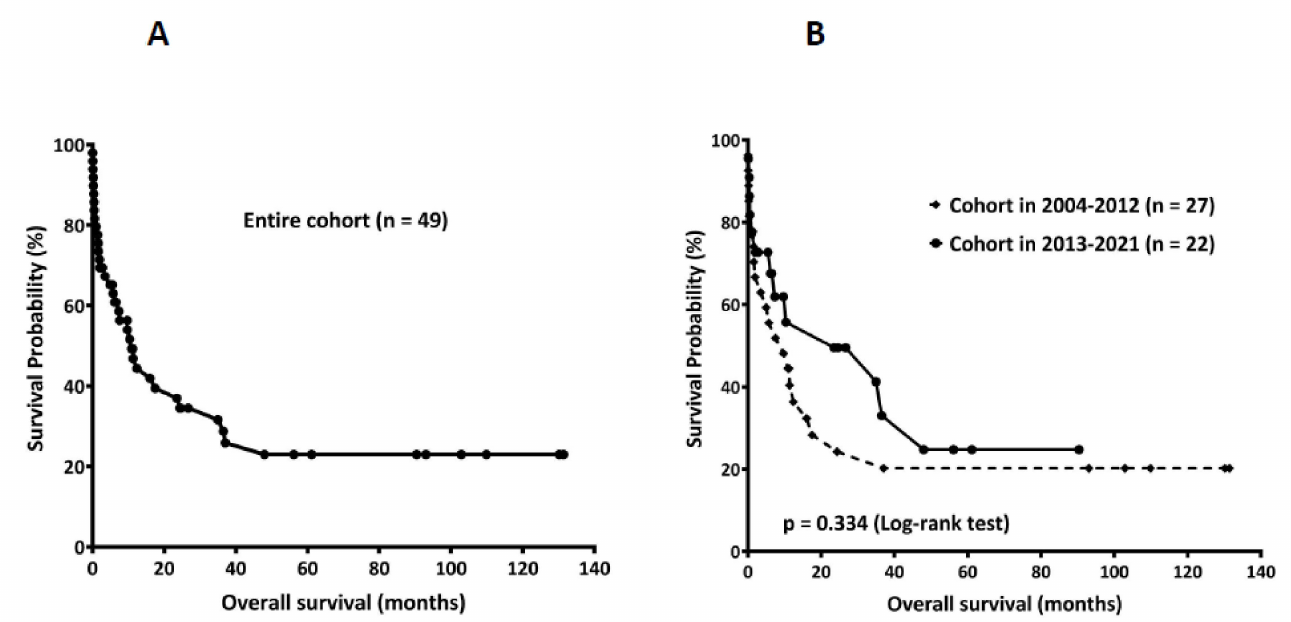
Figure 1. The overall survival (OS) in patients of lymphoma-associated hemophagocytic lymphohistiocytosis. ( A ) The median OS of the whole study population ( n = 49) was 10.9 ± 3.0 months. ( B ) The median OS was 9.7 ± 4.5 and 23.6 ± 19.8 months in the 2004–2012 group ( n = 27) and 2013–2021 group ( n = 22), respectively ( p =